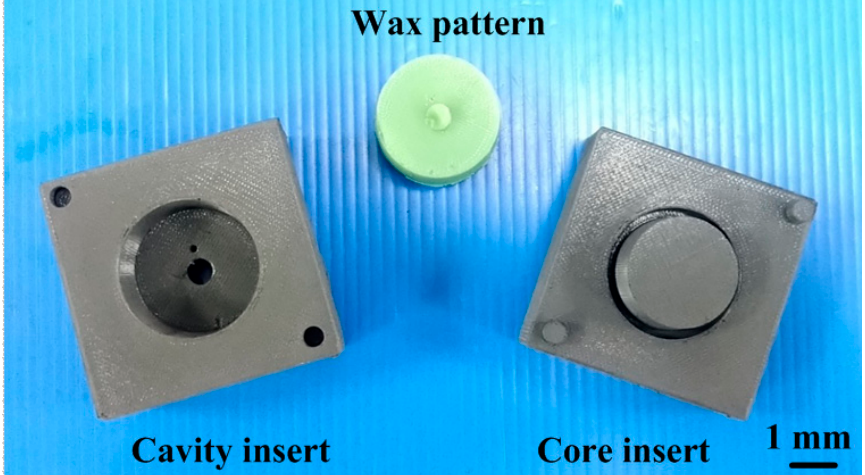
Figure 20. Photo of a molded wax pattern.